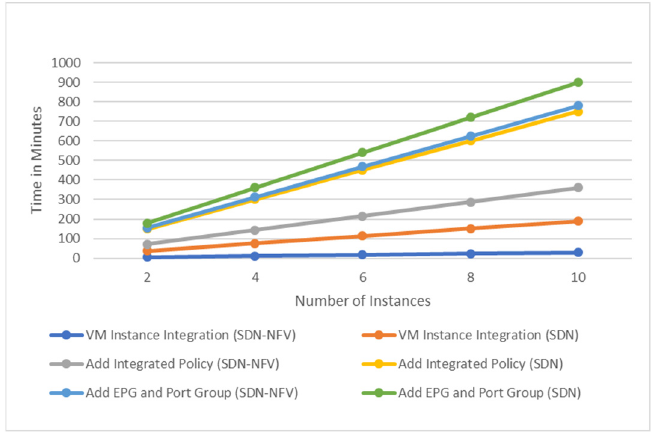
Figure 18. Manageability evaluation